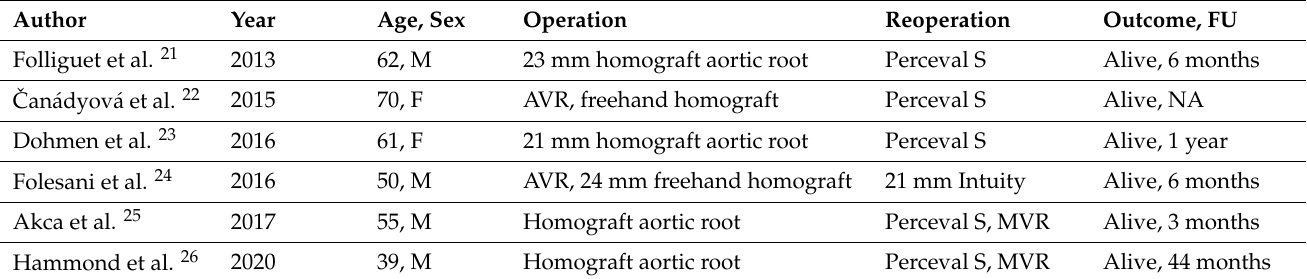
Table 3. Reoperation for failed homografts using Perceval of Intuity bioprostheses. Summary of reported